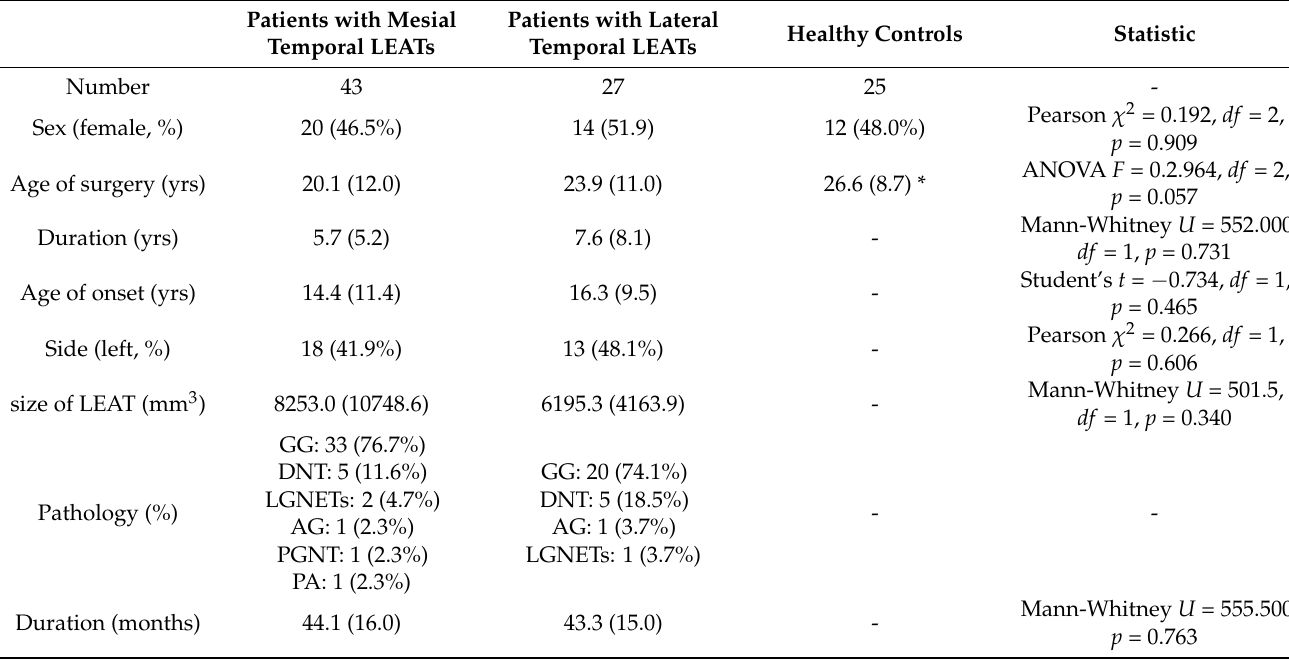
Table 1. Patient demographic and clinical